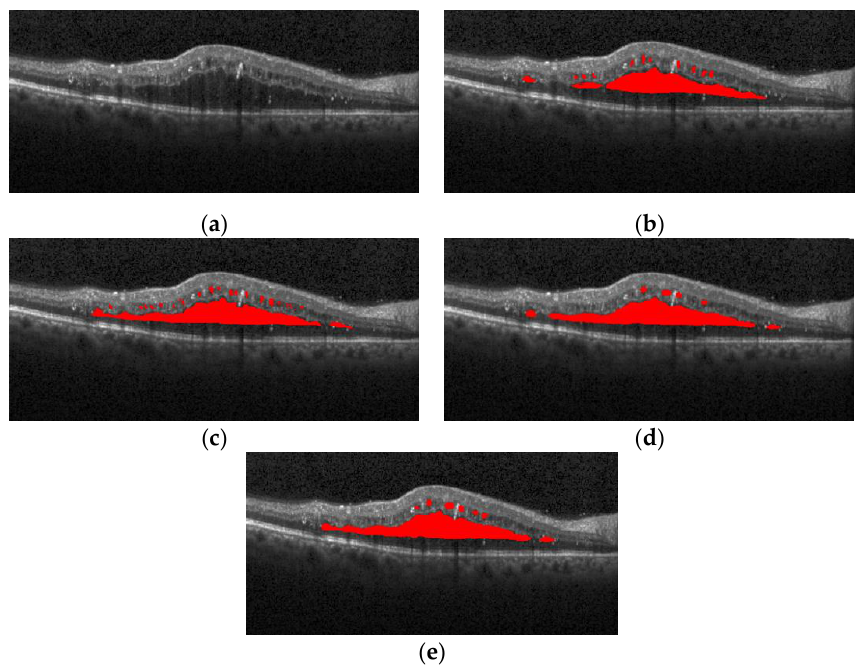
Figure 17. Comparison of segmentation results with the expert 2 annotations as the ground truth: ( a ) original image; ( b ) expert 1 annotations; ( c ) expert 2 annotations; ( d ) ReLayNet predictions; ( e ) proposed method predictions. Appl. Sci. 2020 , 10 , x FOR PEER REVIEW Figure 18. Comparison of ROC curves with expert 2 annotations as the ground truth.